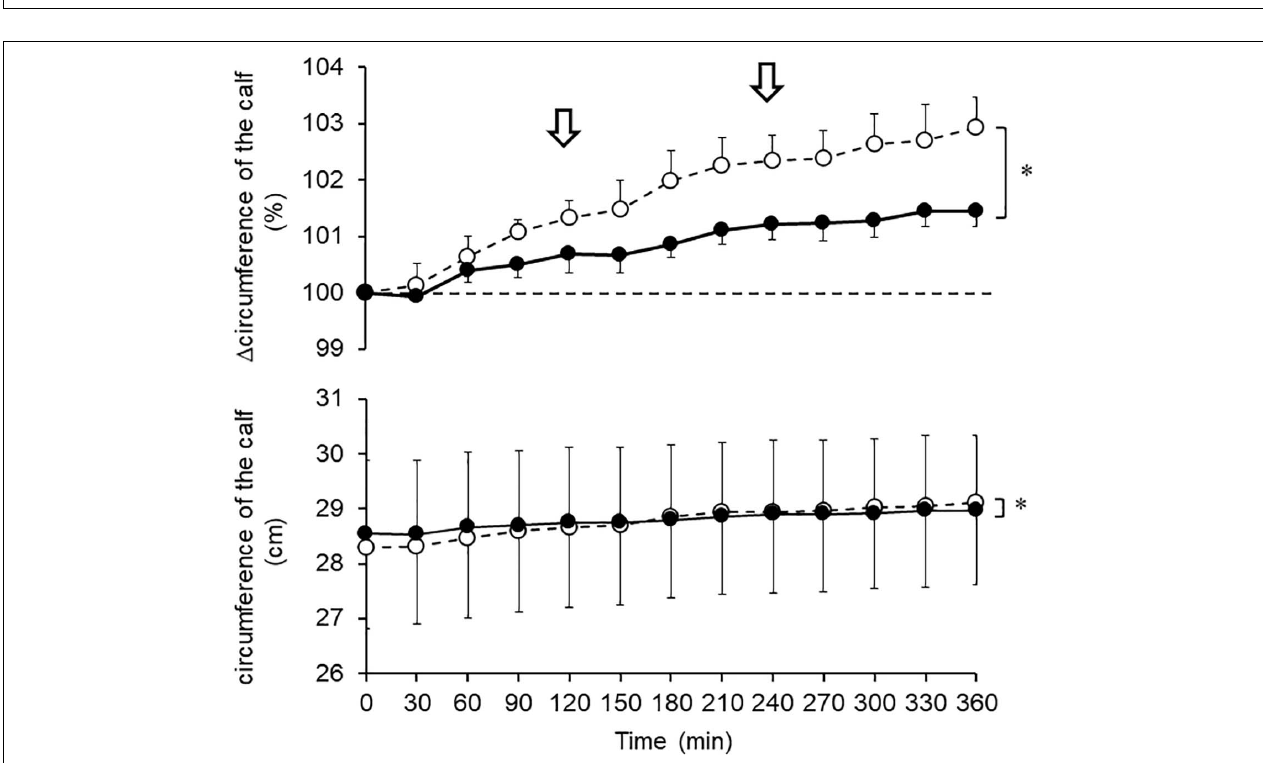
FIGURE 4 | Changes in circumference of the calf after 1,000 mg of G-Hsp ( • ) and Placebo ( ◦ ) beverage ingestion. The arrow indicates the walking for urination, mean and SE, n = 6, Asterisks indicate significant differences ( ∗ P < 0.05).